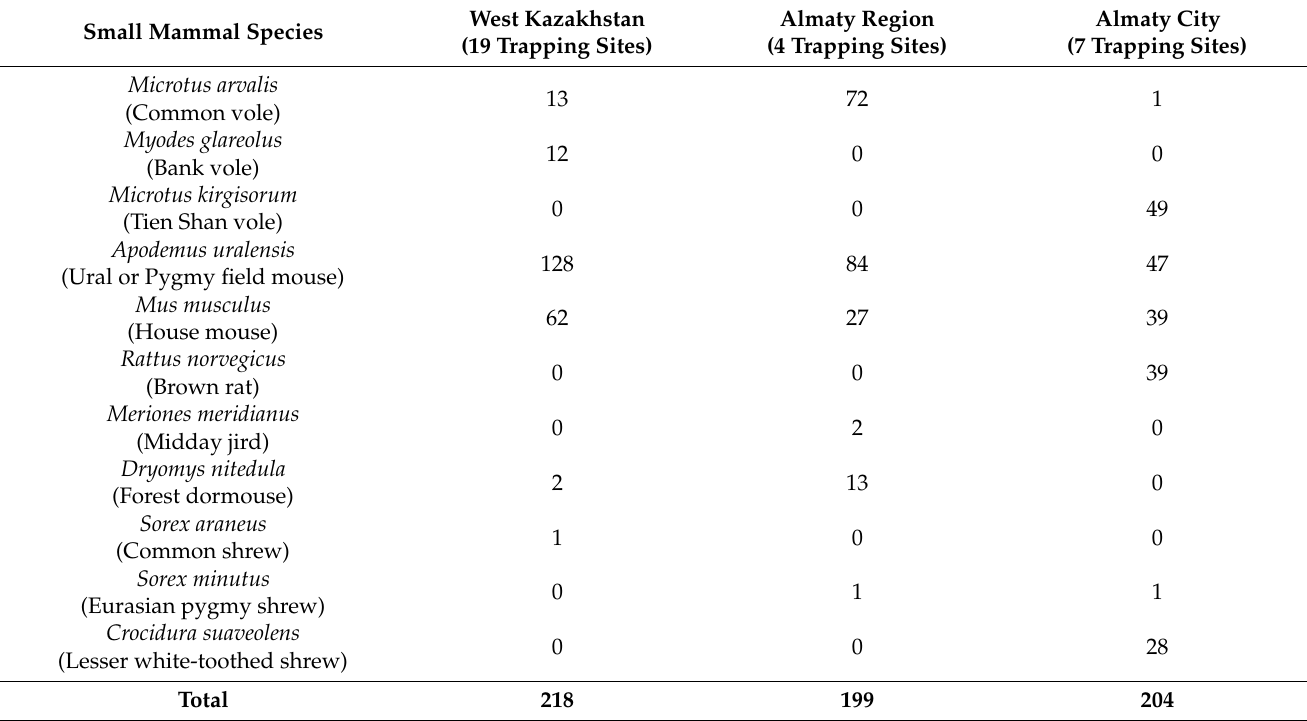
Table 1. All species captured in snap traps in the sampling areas of interest.